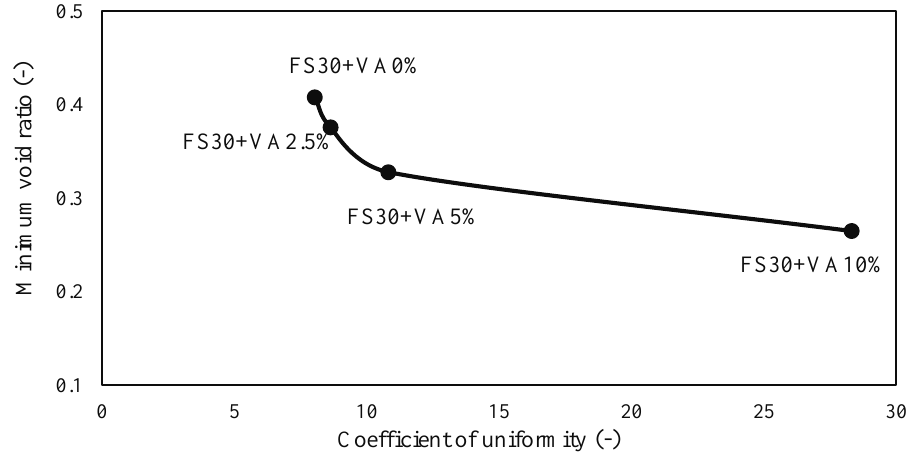
Figure 3. Variation of minimum void ratio (e min) with the coefficient of uniformity (Cu) of FS30 and different binder contents.